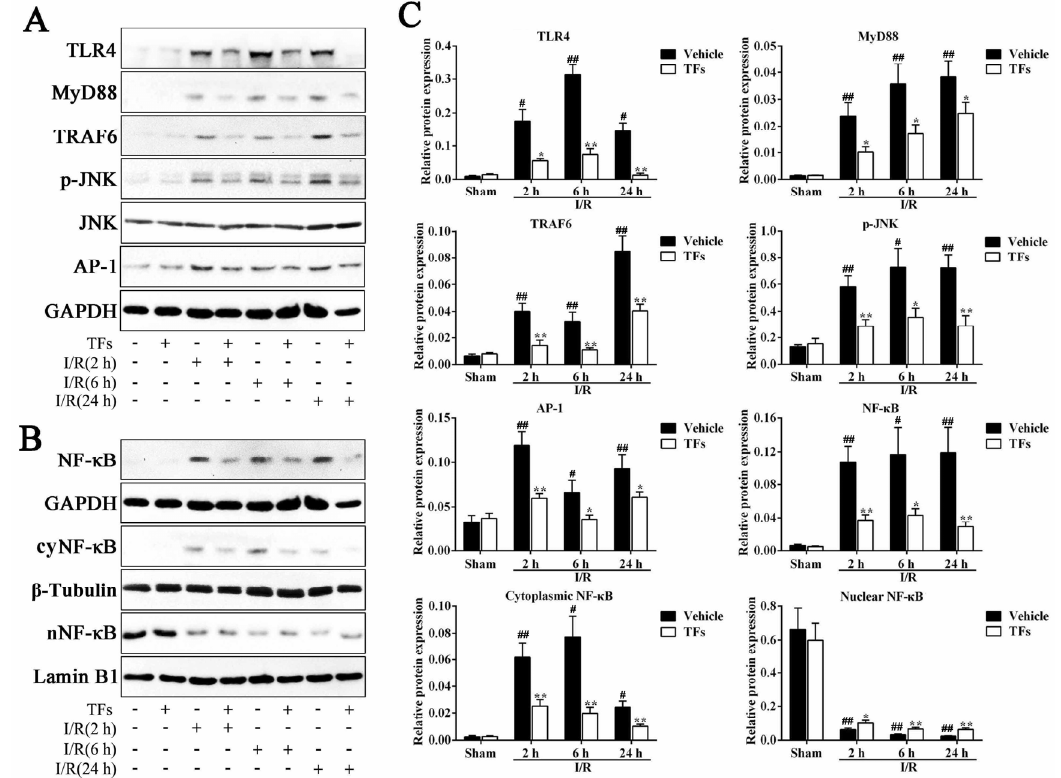
Figure 6. TFs inhibited the TLR4 signaling pathway after I/R injury. ( A ) Effects of TFs on TLR4, MyD88, TRAF6, p-JNK, and AP-1 protein expression in liver tissue after 1 h of ischemia and different times of reperfusion (2 h, 6 h, and 24 h); ( B ) effects of TFs on NF- κ B, nNF- κ B (nucleus NF- κ B), and cyNF- κ B (cytoplasm NF- κ B) proteins expression in liver tissue after 1 h of ischemia and different times of reperfusion (2 h, 6 h, and 24 h); and ( C ) statistical analysis of the Western blot assay. Data are presented as the mean ± SD ( n = 6). # p < 0.05 and ## p < 0.01 versus sham; * p < 0.05 and ** p < 0.01 versus vehicle.